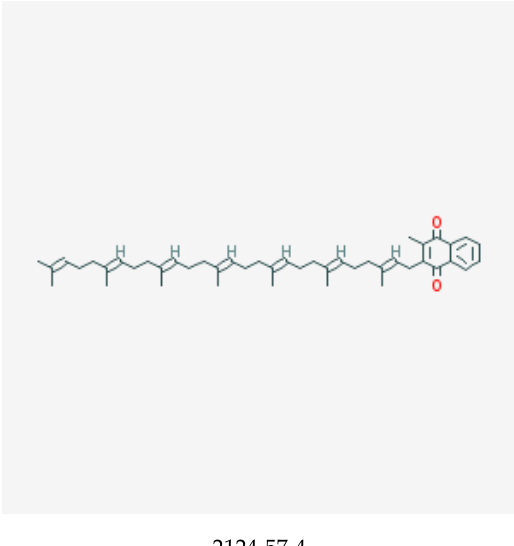
Figure 4. Chemical structure of menaquinone-7 with its CASRN [95].